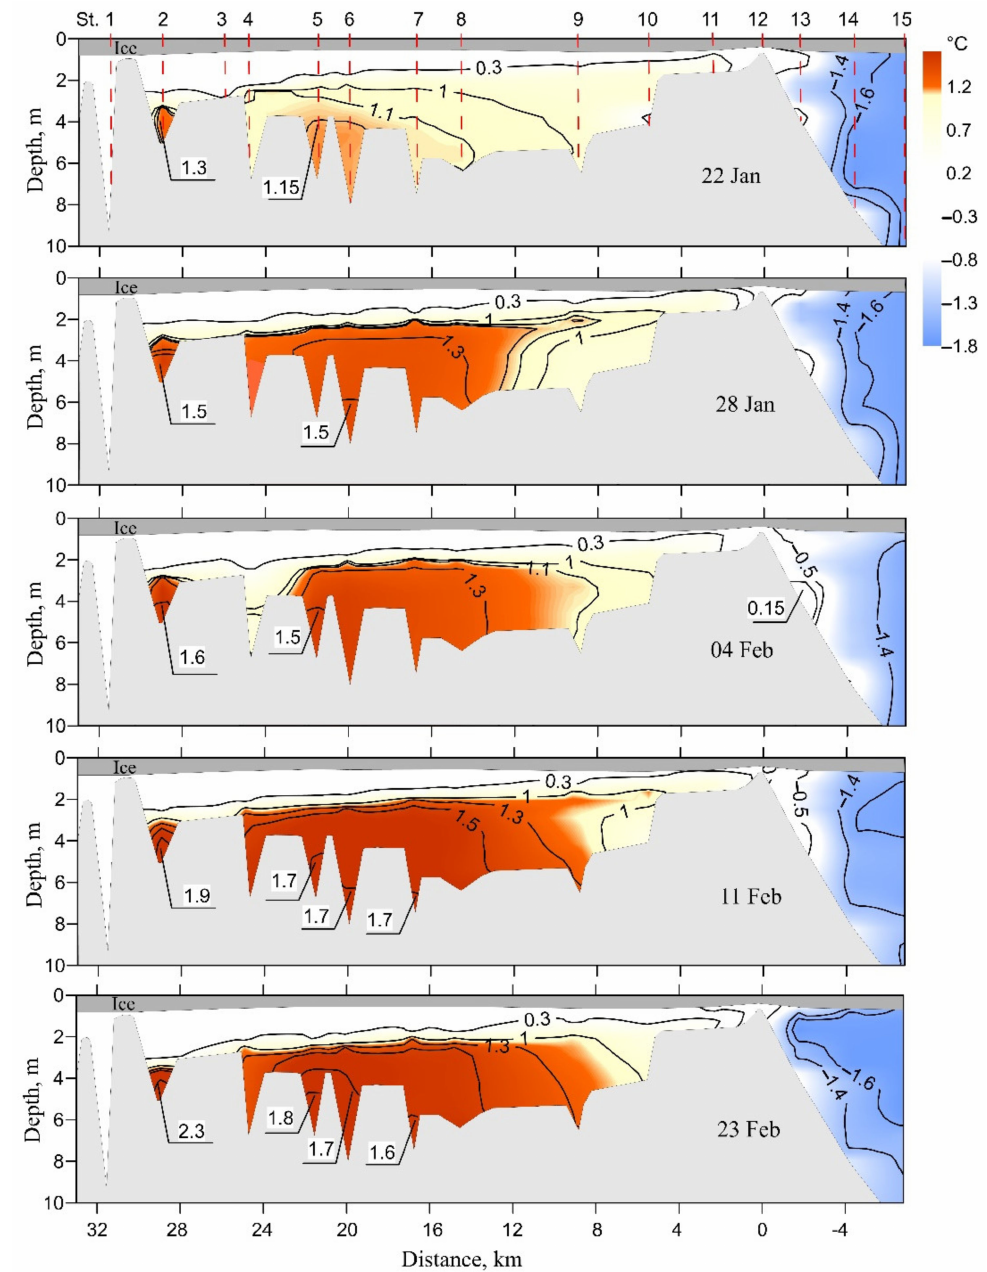
Figure 3. Water temperature on transect obtained from 22 Jan. 2022 to 23 Feb. 2022. The position of monitoring stations is shown by dotted red lines. Positive values on the x -axis—distance from the river mouth bar (St. 12) to upstream, negative values—to